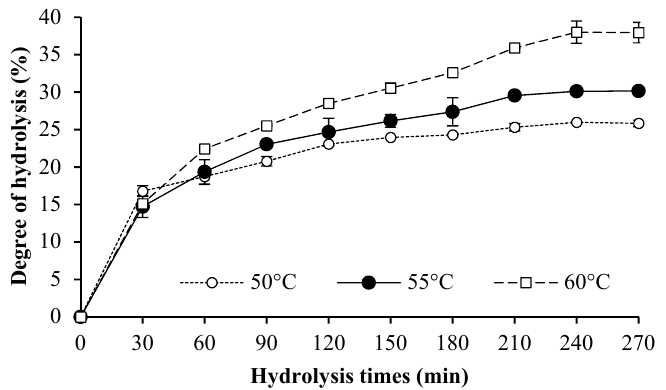
Figure 2. DH curve of HC from salmon skin prepared at different temperatures. Hydrolysis was conducted at pH 8 using mixed proteases (3%P + 4%A) for 270 min. Bars represent the standard deviation ( n = 3).